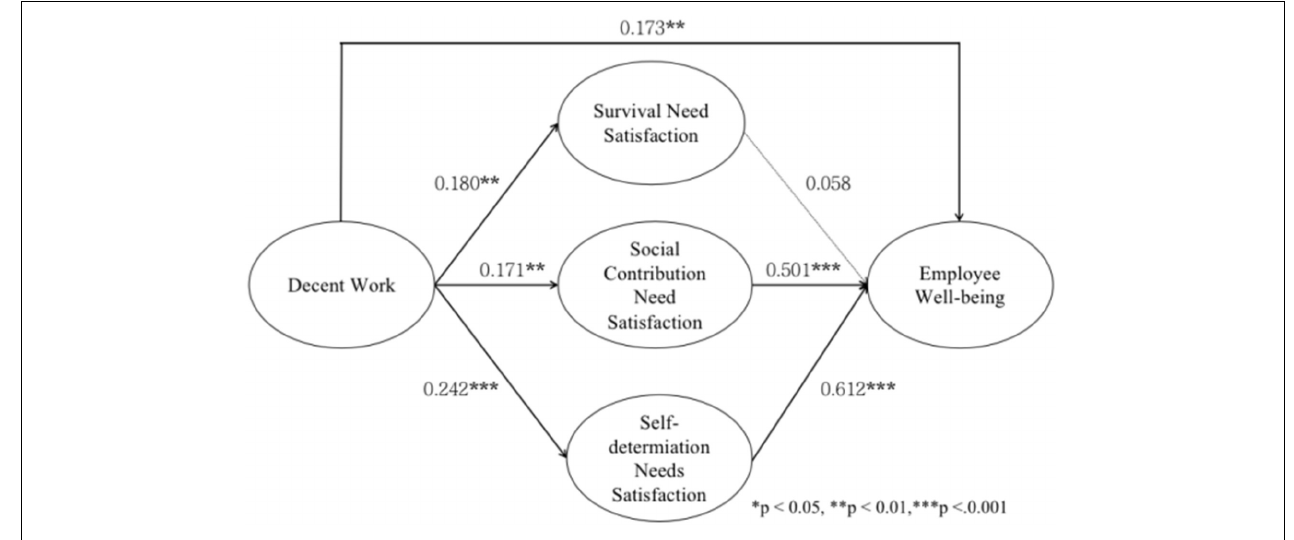
FIGURE 2 | Results of path analysis. * p < 0.05, ** p < 0.01, *** p < 0.001.